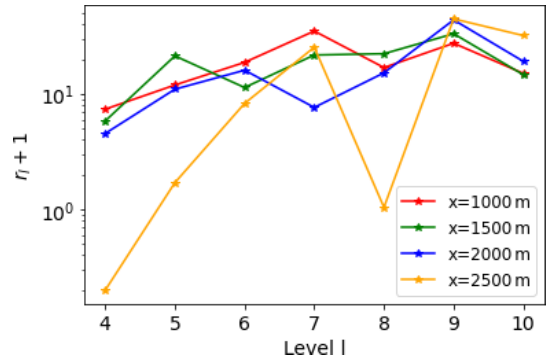
Figure 8. Error (RMSE) between the MLMF result and the Monte Carlo (MC) result as the tolerance value (cid:15) in Eq. (14) is varied in the non-breaking wave test case. This is compared to the error (RMSE) when varying (cid:15) in Eq. (B7) when using MLMC with XBeach.